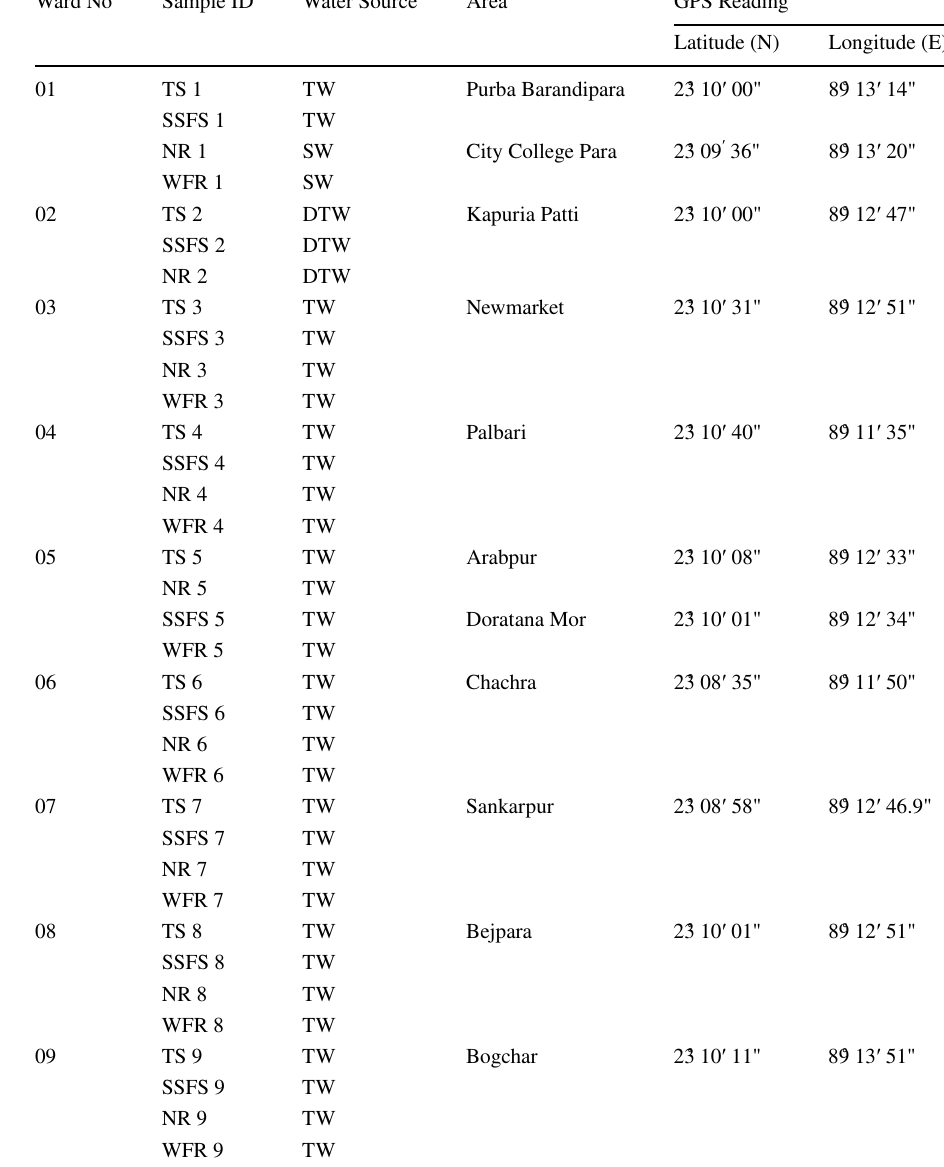
global positioning system (GPS) condemnation of the different usual food stalls in 9 wards of Jashore